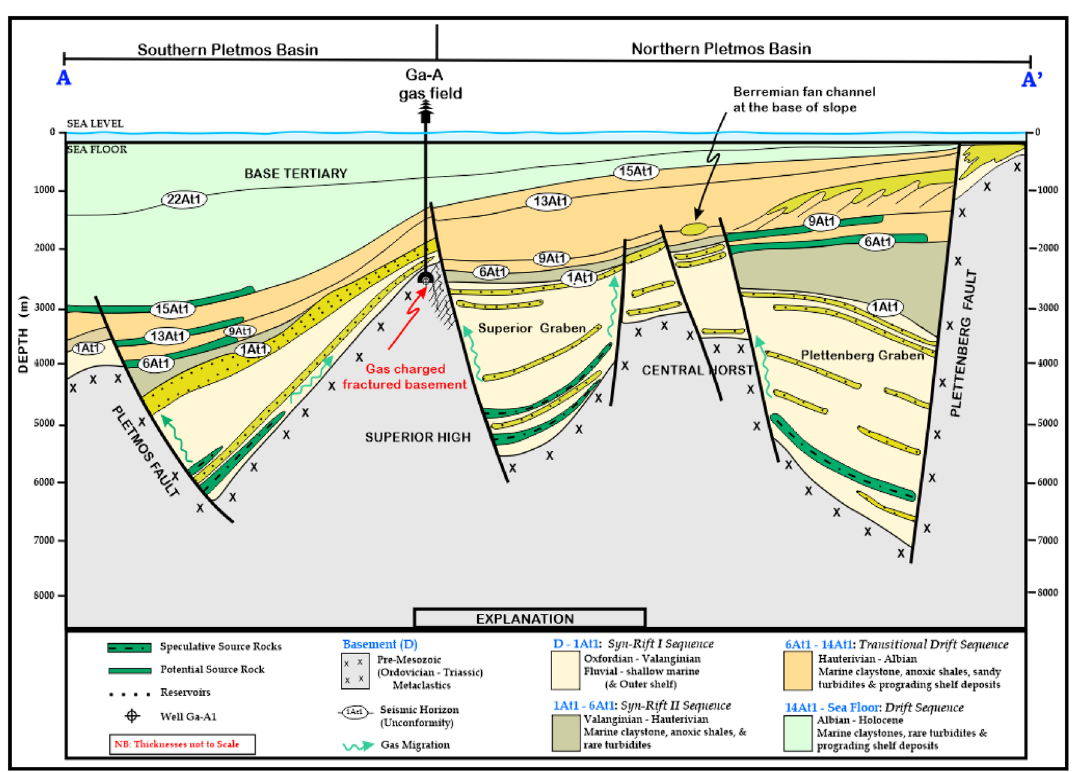
Fig. 2 Schematic section across the Pletmos Basin, illustrating struc- tural styles and stratigraphic subdivision adapted from Roux and Davids (2009). The major faults shown arose from the rifting asso-